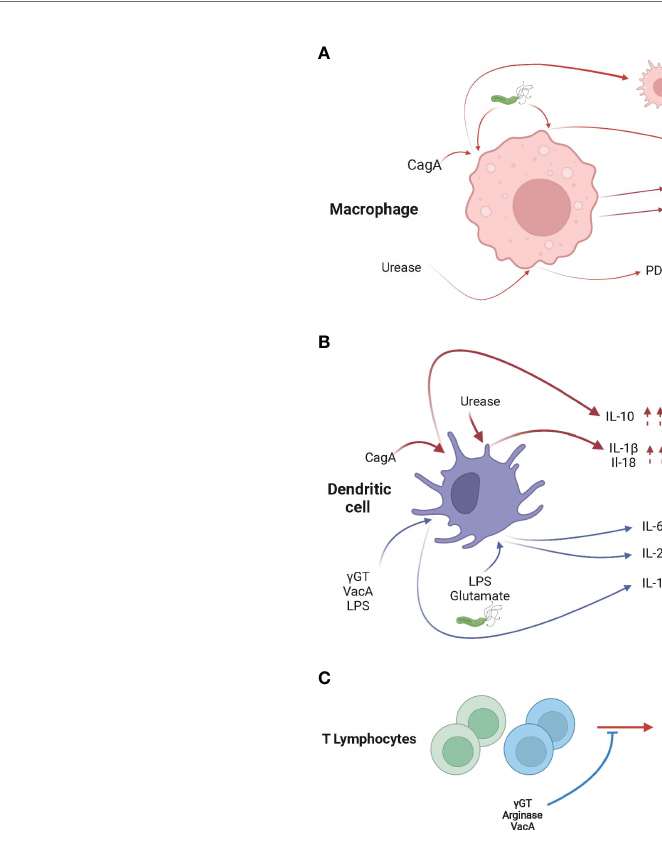
FIGURE 1 | H pylori infection modulates the activity of macrophages, dendritic cells and T lymphocytes. (A) When in contact with H pylori , cytotoxin-associated gene A (CagA) and/or urease, skew macrophages toward an M2 phenotype, which promotes Treg cell differentiation, inhibits CD8 + T cell responses and/or promotes apoptosis. (B) H pylori , CagA, g -glutamyl transpeptidase ( g GT), vacuolating cytotoxin A (VacA), Lipopolysaccharide (LPS), glutamate and urease trigger the differentiation of tolerogenic DCs, leading to the Treg cell-skewed Th response. (C) g GT, VacA and Arginase inhibit the proliferation of CD4 + and CD8 + T